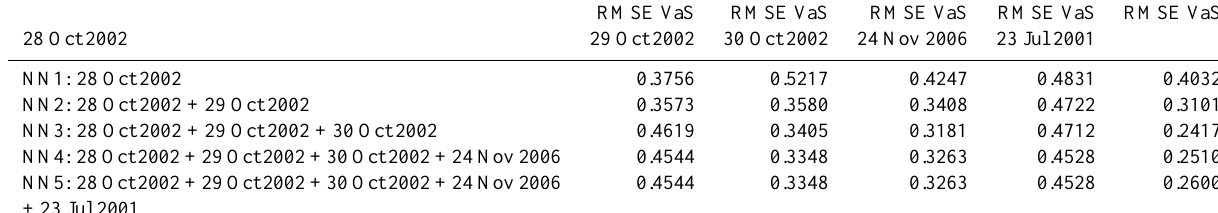
Table 5. The rmse values for the extracted Validations sets.